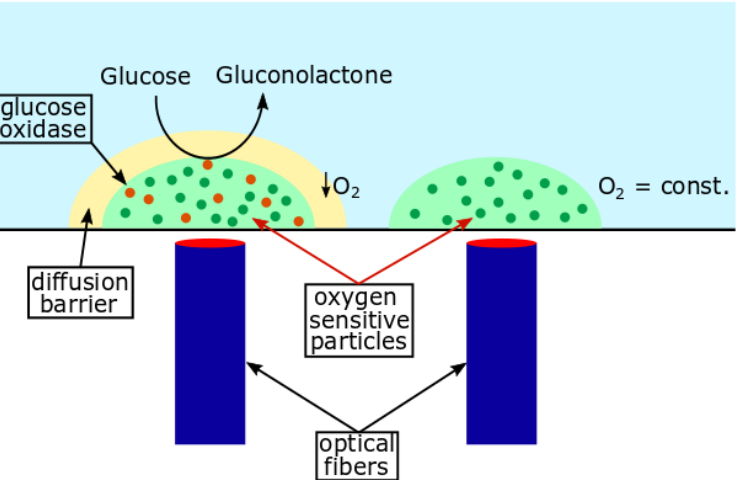
Figure 1. Working principle of the glucose sensor: glucose diffuses through the diffusion barrier and is oxidized aerobically by glucose oxidase to gluconolactone. Hence, the oxygen partial pressure in the glucose sensor declines, while it remains constant in a separated oxygen sensor. The difference in oxygen partial pressure between the two sensors is proportional to the glucose concentration. A read-out device is connected to the sensor spots via optical fibers.